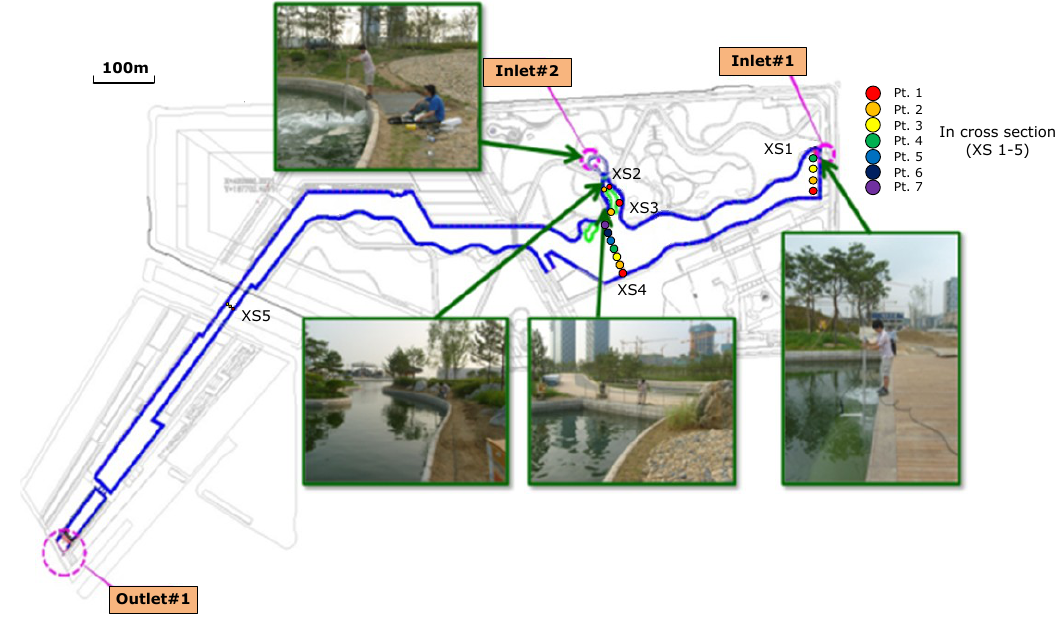
Figure 3. Sampling points (Pt.) for hydraulic characteristics monitoring in the cross section